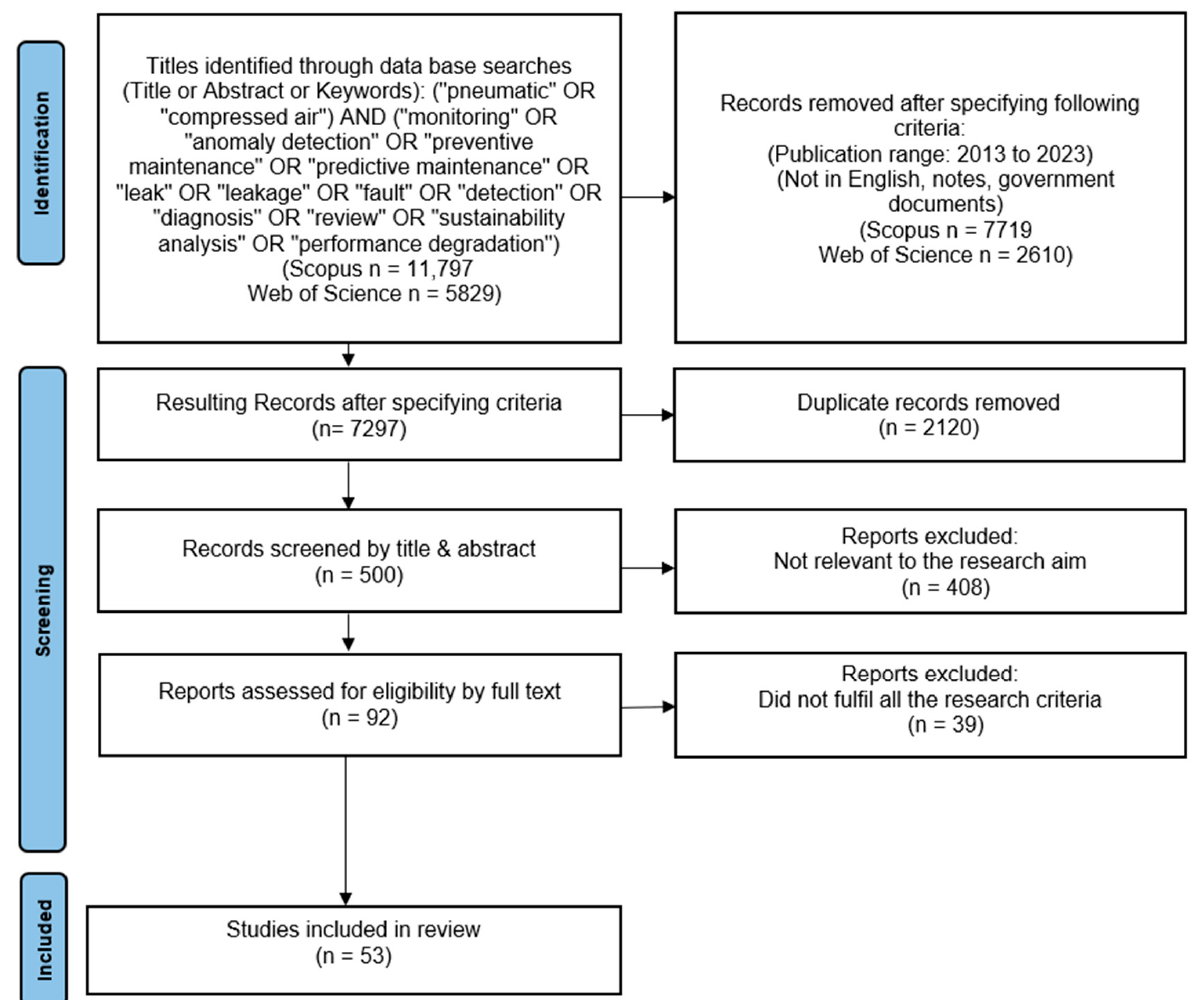
Figure 1. A summary of the PRISMA process adopted for this review [44].